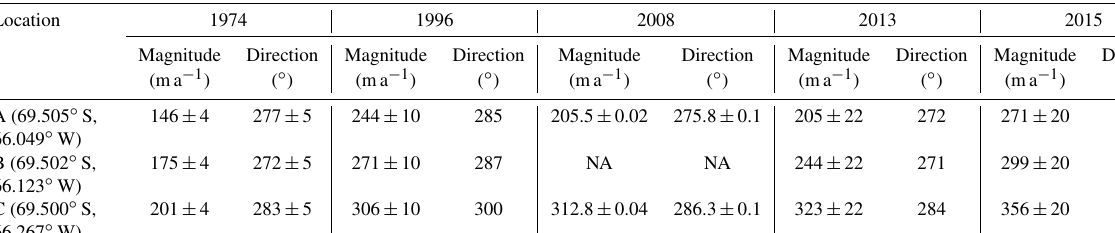
Table 2. Comparison of surface velocities and flow directions at Fleming Glacier obtained by an optical survey in 1974 (Doake, 1975), SAR interferometry in 1996 (Rignot et al., 2005), GPS measurements in 2008 (Wendt et al., 2010) and SAR intensity tracking in 2013. Velocities and flow directions in 2013 were derived from intensity tracking applied on two TSX–TDX acquisitions on 19 and 30 December 2013. Velocities in 2015 are from Zhao et al. (2017). For the locations of the measuring sites see Fig. 1.